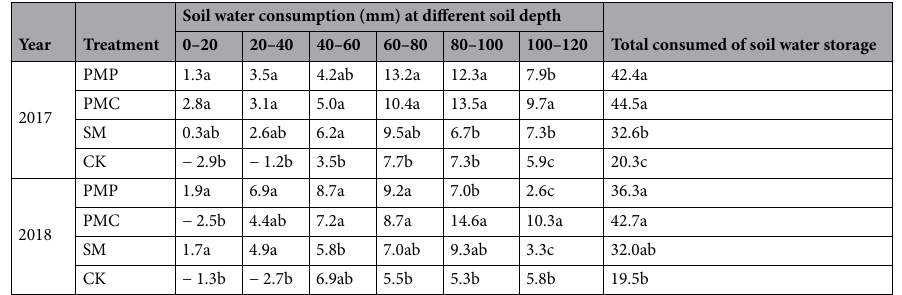
Table 3. Consumed water storage in different soil layers under different cultivation practices in Hesheng County of Gansu Province, China, in 2017 and 2018. Different letters indicate significant differences (P < 0.05) between treatments for soil water consumption and total consumption of soil water storage.